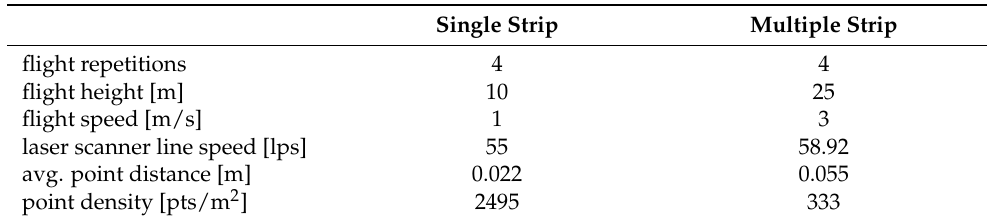
Table 3. UAV flight parameters for single and multiple strip measurements.